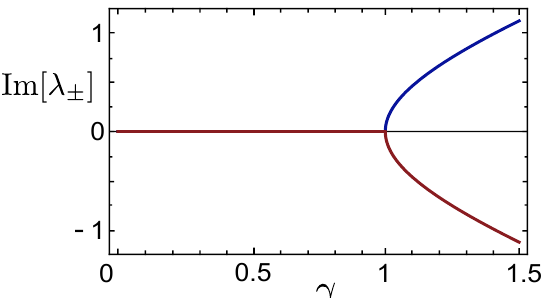
Figure A1. Imaginary part of the eigenvalues λ ± in Equation (A3). For γ < J (= 1 ) we have a PT symmetric phase with real eigenvalues. Above the bifurcation point at γ = J , the system enters the PT broken phase with imaginary